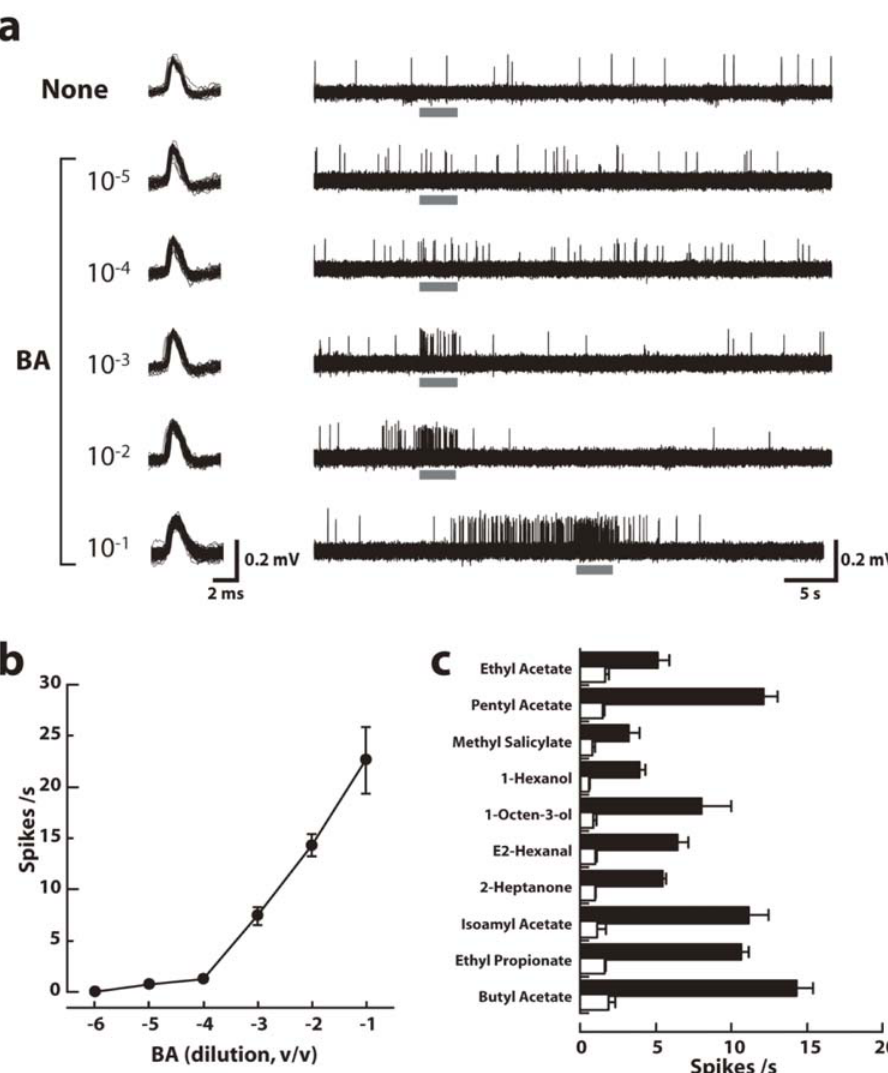
Figure 2. Responses to odors in bitter-sensitive GRNs expressing Or22a co-expressed with Or83b . a. Sample recordings from an i-type gustatory sensillum expressing Or22a + Or83b driven by Gr66a -Gal4, and stimulated with increasing concentrations of butyl acetate diluted in paraffin oil (dilution of 10 2 5 to 10 2 1 , solvent: paraffin oil only). The stimulation is marked by a horizontal grey bar. Note that the response started before the capillary contacted the sensillum at the higher concentrations (10 2 2 and 10 2 1 ), demonstrating that air-borne chemicals stimulate the altered GRNs at high concentrations. b. Sensitivity of the altered GRNs to butyl acetate (BA) (mean 6 S.E.M.; n=4 to 19 trials). Ordinates: firing frequency measured during the 2 s stimulation. Abscissa: BA dilutions along a logarithmic scale. c. Odor response spectrum of GRNs expressing Or22a + Or83b ; all odorants were diluted 10 2 2 in paraffin oil. Black bars: OR22a + OR83b; Open bar: wild type, mean 6 S.E.M.; n=4 , 17.